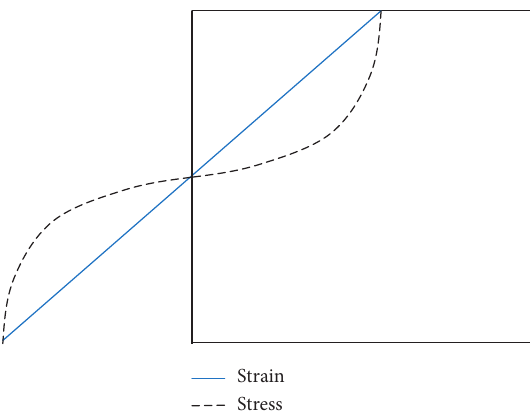
Figure 12: Axial strain (linear) and stress (nonlinear) distribution through the sample